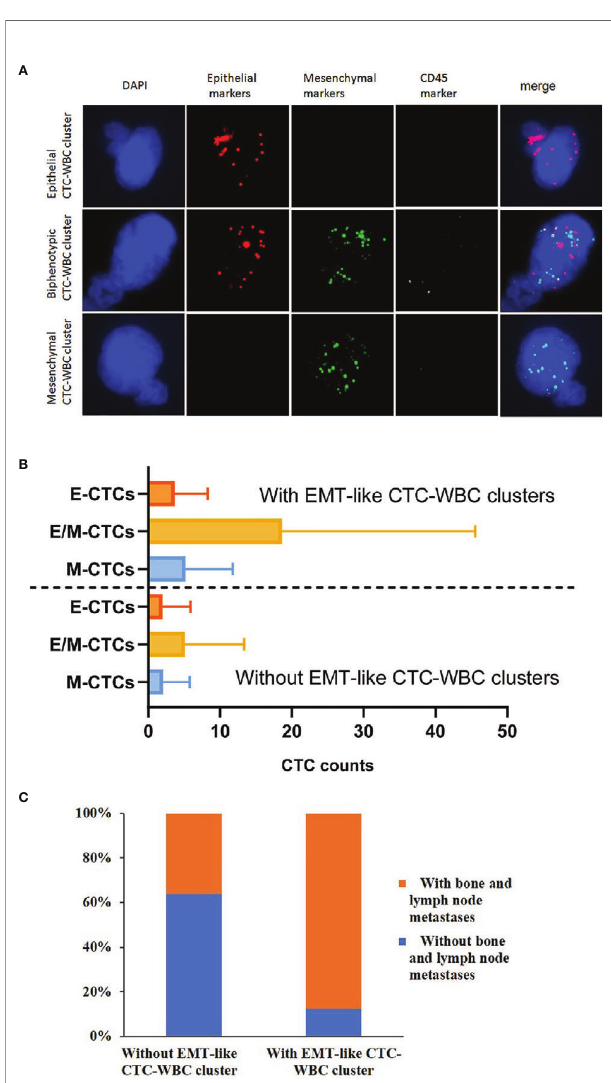
FIGURE 2 | Association of the detection of EMT-like CTC-WBC clusters with different subtypes of CTCs and the clinicopathological characteristics. (A) Representative images of CTC-WBC clusters classi fi ed by categorical markers. (B) The distribution of different CTC subtypes in the patients with EMT-like CTC-WBC clusters and those patients without. (C) Association between the detection of EMT-like CTC-WBC clusters and metastatic sites.